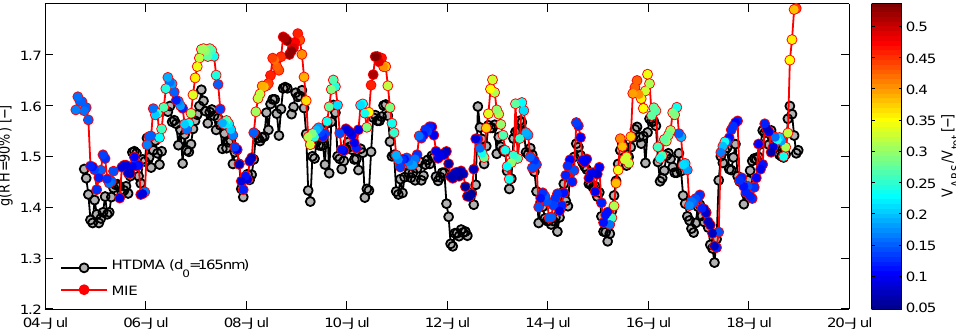
Fig. 6. Time series of the hygroscopic growth factor measured by the H-TDMA (black line) and retrieved from WetNeph, DryNeph, SMPS, APS measurements and Mie theory (red line). The color code denotes the coarse mode volume fraction measured by the APS and SMPS.